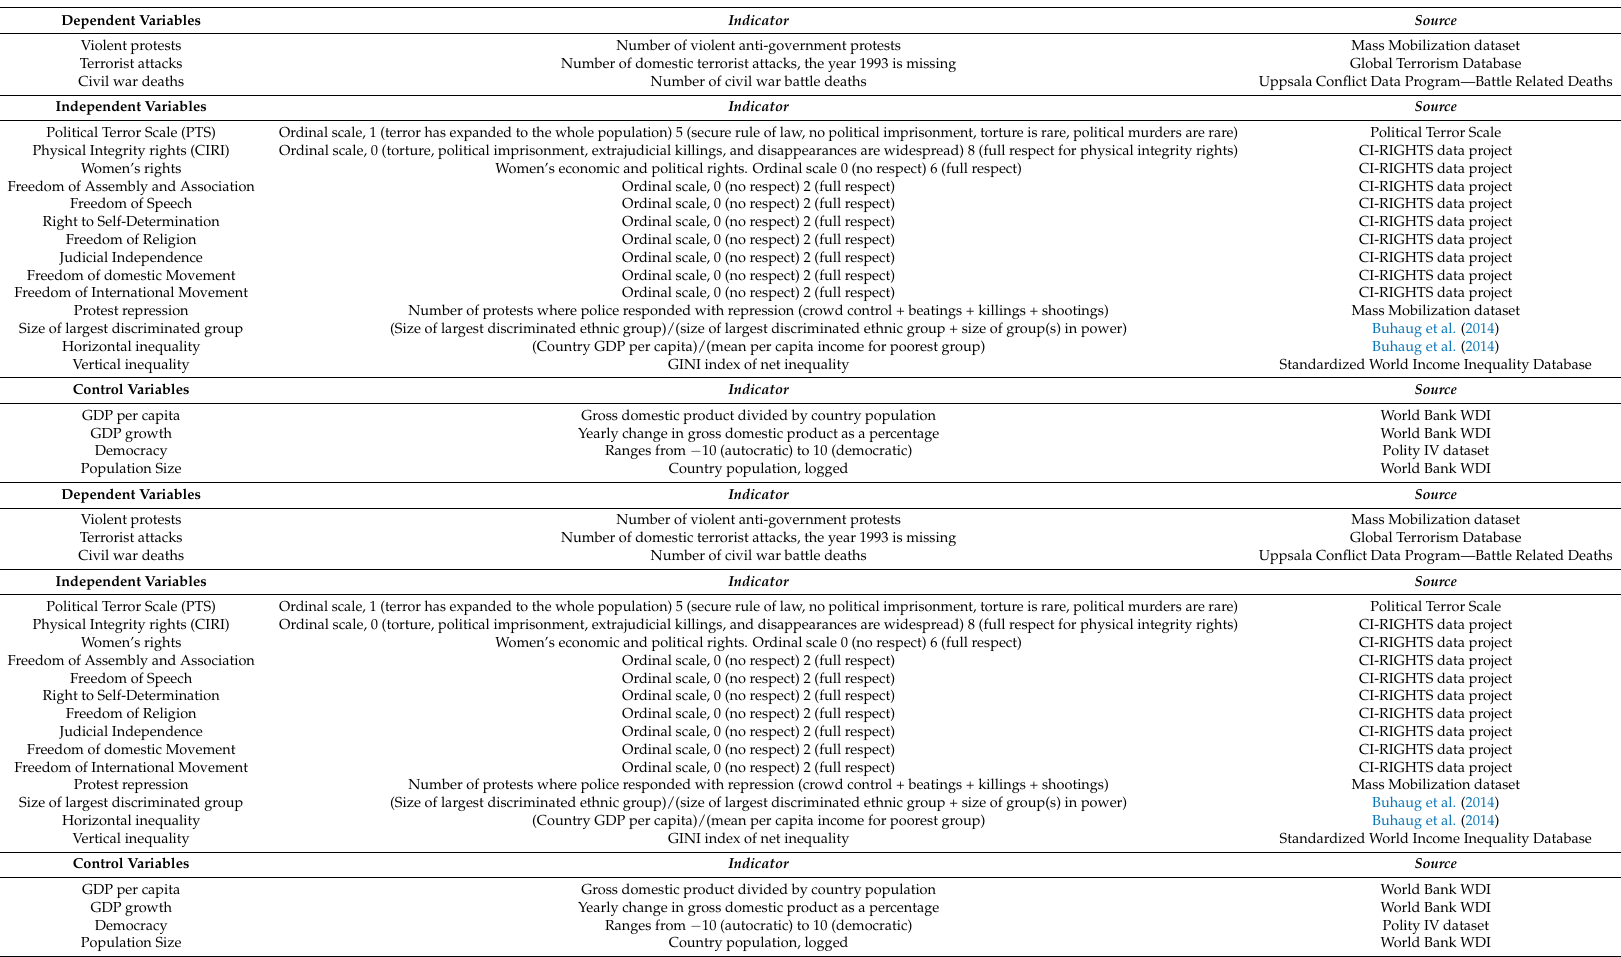
Table A1. Variables and